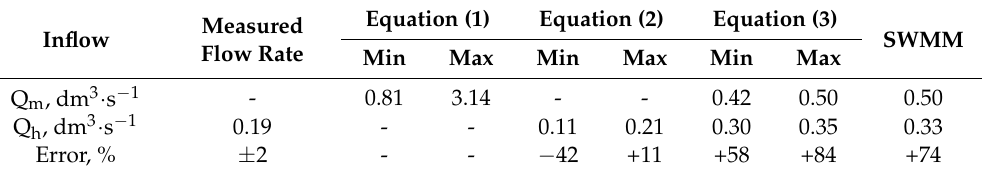
Table 6. Comparison of 1-min and hourly maximum wastewater inflows to pumping station PS_2.